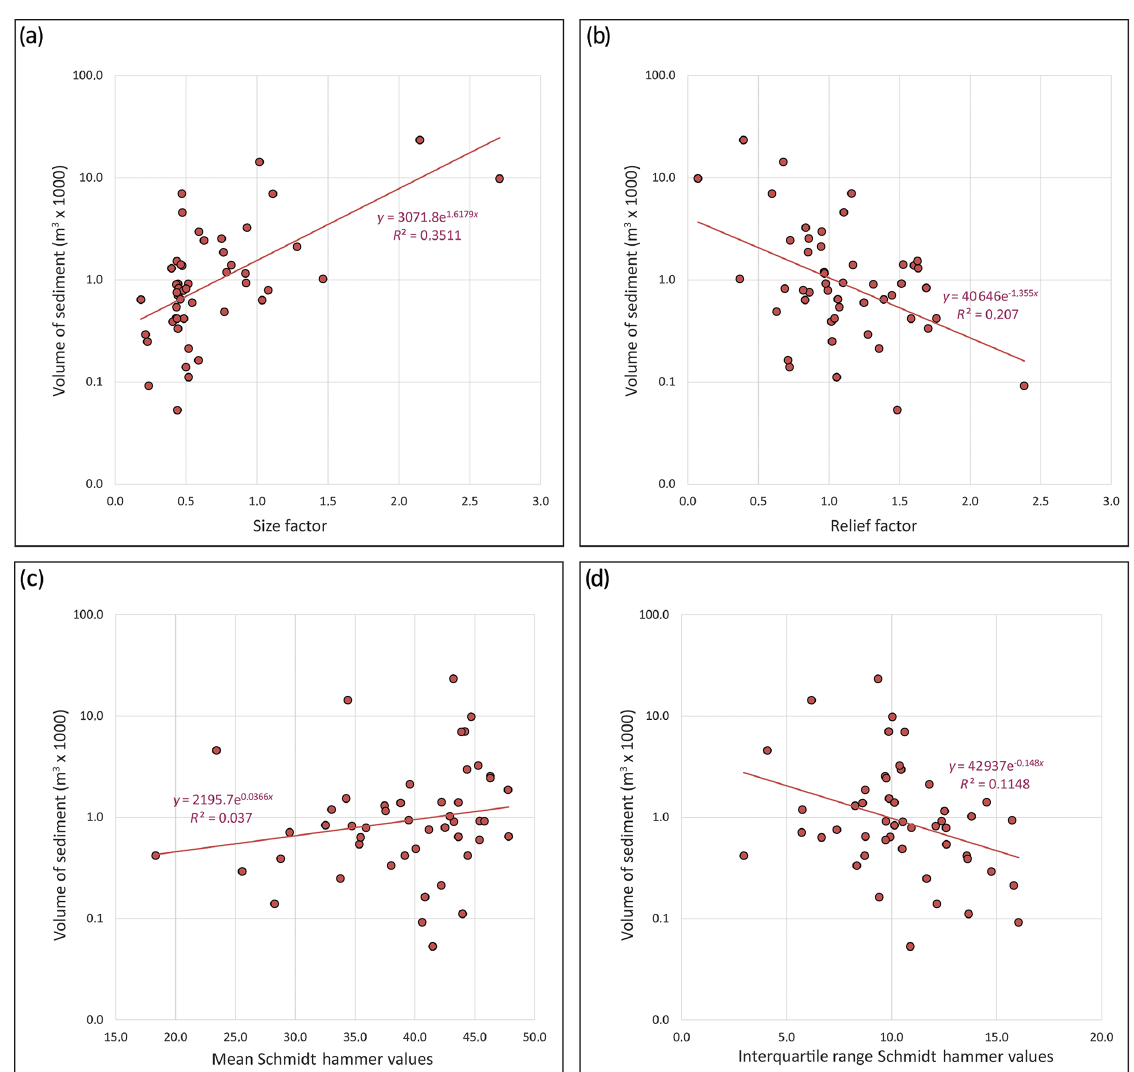
Figure 9. Graphics showing the relationship between different studied factors in catchments with sediment volumes of debris flow deposits. (a) Relationship between size factor and sediment volumes. (b) Relationship between relief factor and sediment volumes. (c) Relationship between mean Schmidt hammer values and sediment volumes. (d) Relationship between interquartile range Schmidt hammer values and sediment